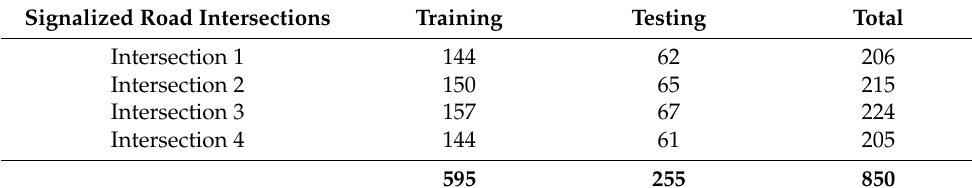
Table 4. The breakdown of the traffic